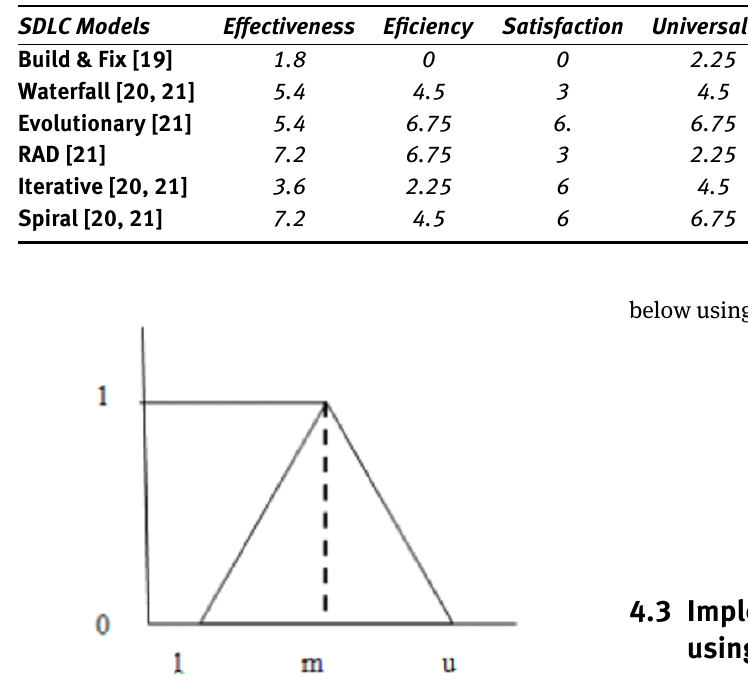
Figure 3: Triangular fuzzy number (TFN)